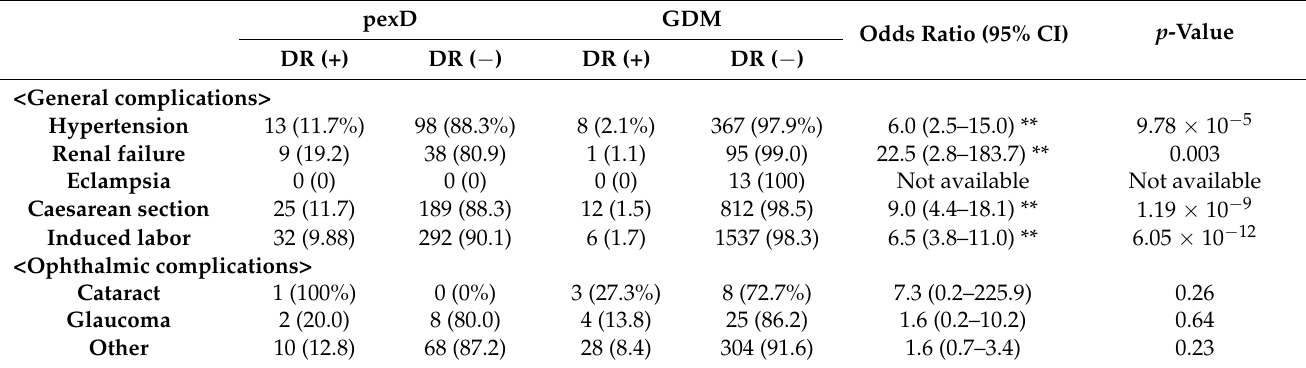
Table 2. Complications during pregnancy from Japanese claim database cohort.